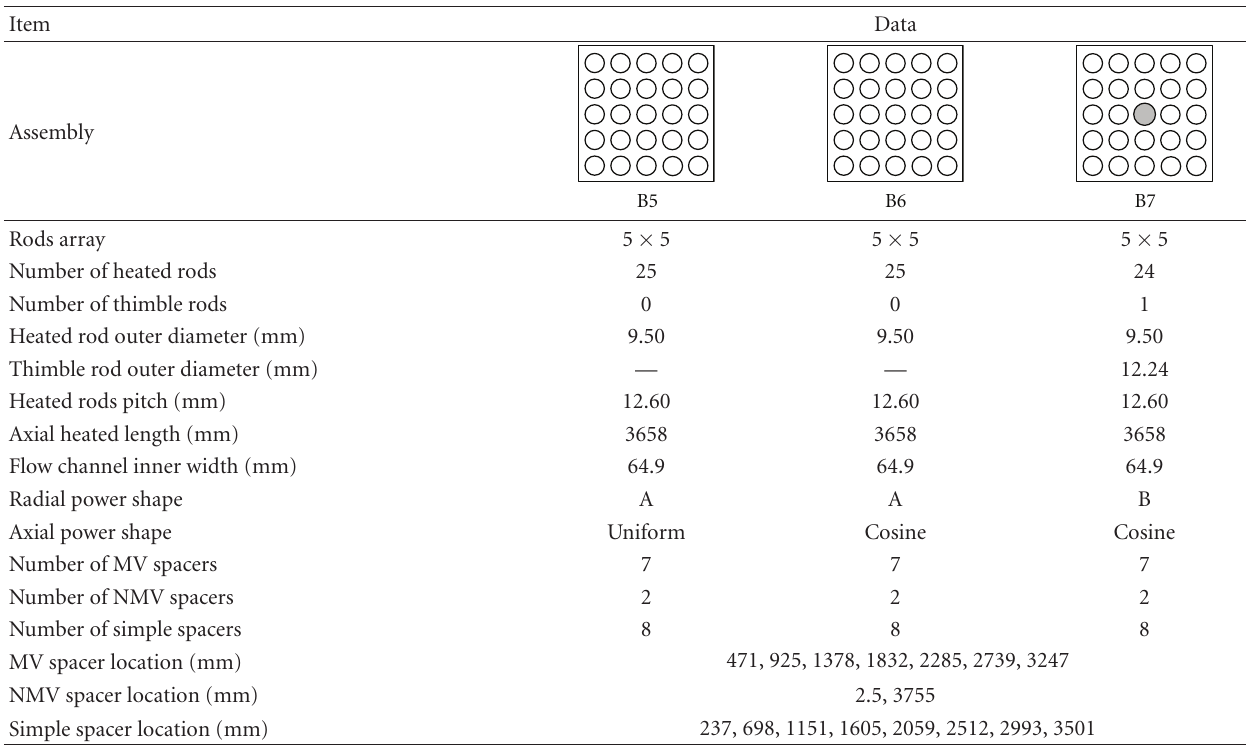
Table 3: Geometry and power shape for each bundle [2].